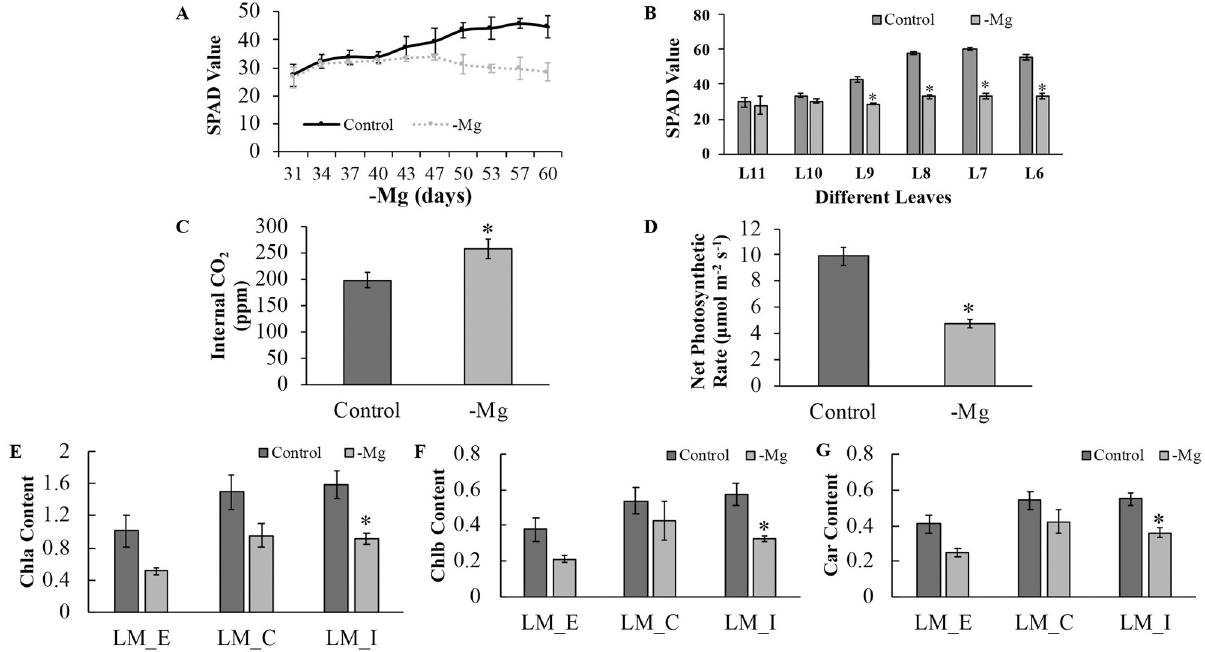
Fig 2. Physiological responses to MD stress among banana leaves. (A) SPAD values of L9 recorded from 31 to 60 days in the control and MD treatments ( n = 5). ( B) SPAD value variation from L6 to L11 on the 42nd day in the control and MD treatments ( n = 24). (C) Internal CO 2 concentrations of the MD treatment in L9 ( n = 10). (D) Net photosynthetic rate (Pn) of the MD treatment in L9 ( n = 10). (E-G) Chlb, Chla and Car contents in different regions of L9 ( n = 3). Chla: chlorophyll a; Chlb: chlorophyll b; Car: carotenoid. Data analysis was performed by two-tailed t test , � means significantly different.